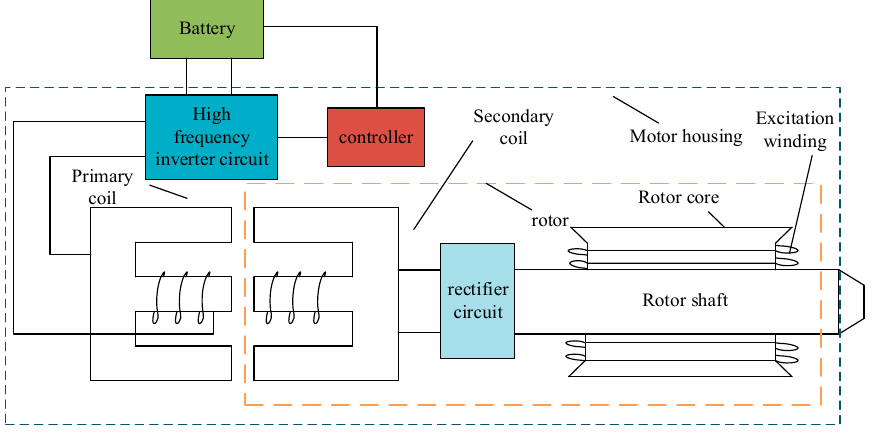
Figure 1. Structure diagram of contactless excitation motor.